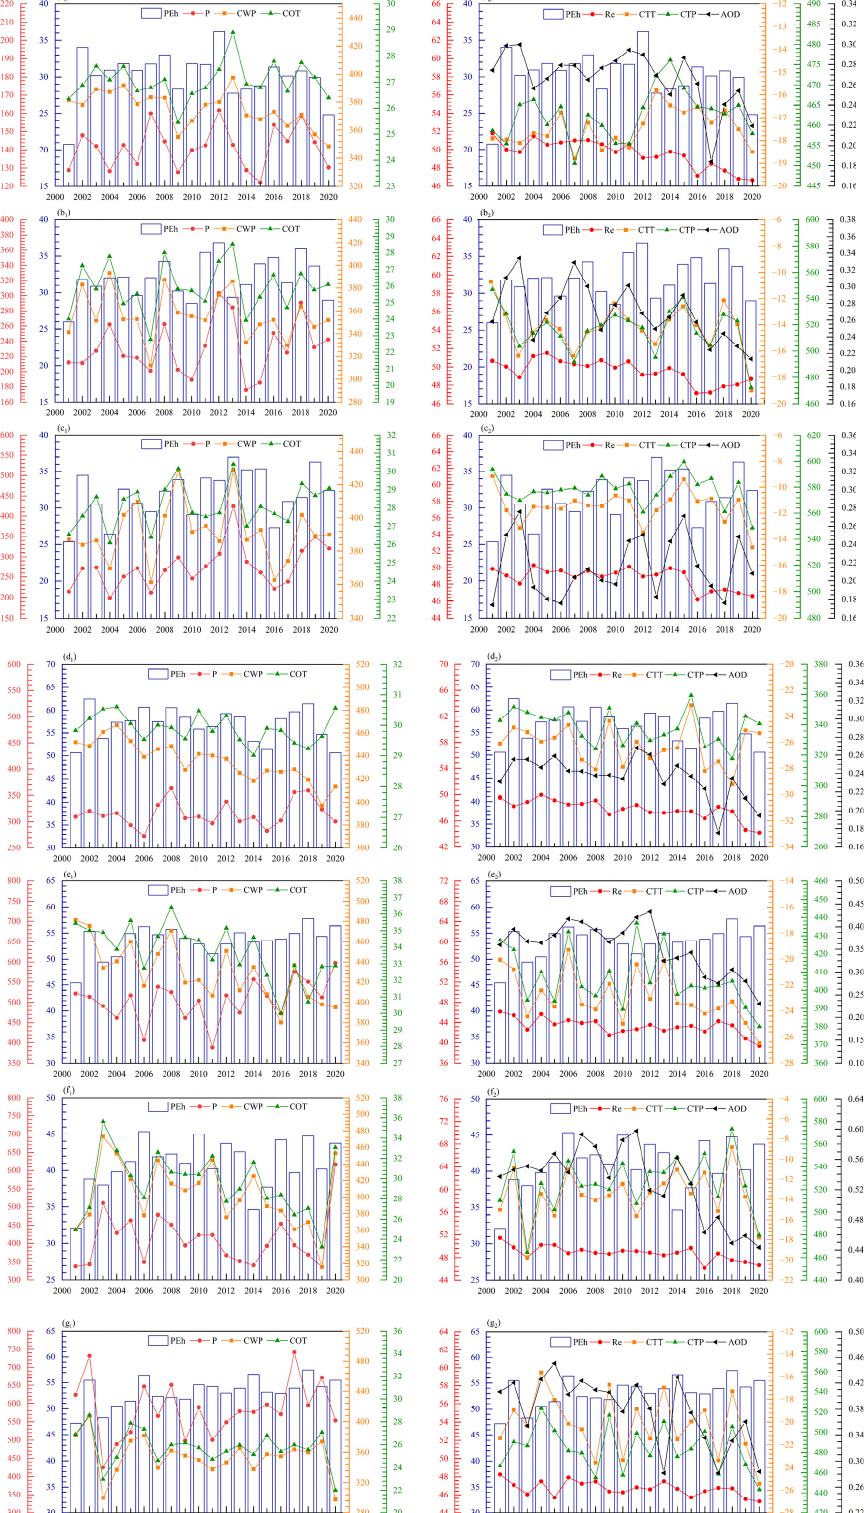
Figure 14. Interannual variability of the PEh (unit: %) and P (unit: mm), averaged daily CWP (unit: g·m − 2 ), COT, Re (unit: um), CTT (unit: °C), CTP (unit: mb), and AOD in the seven sub-regions of China in summer during 2001–2020. ( a 1 , a 2 ) represent NW, ( b 1 , b 2 ) represent NC, ( c 1 , c 2 ) represent NE, ( d 1 , d 2 ) represent TP, ( e 1 , e 2 ) represent SW, ( f 1 , f 2 ) represent CR, ( g 1 , g 2 ) represent SE. The above correlation analysis shows that changes in precipitation, cloud physical parameters, and AOD in different regions can affect the spatial and temporal distribution of PEh in each region to different degrees. The correlations between PEh and each factor for each region in the last 20 years are summarized in Figure 15.